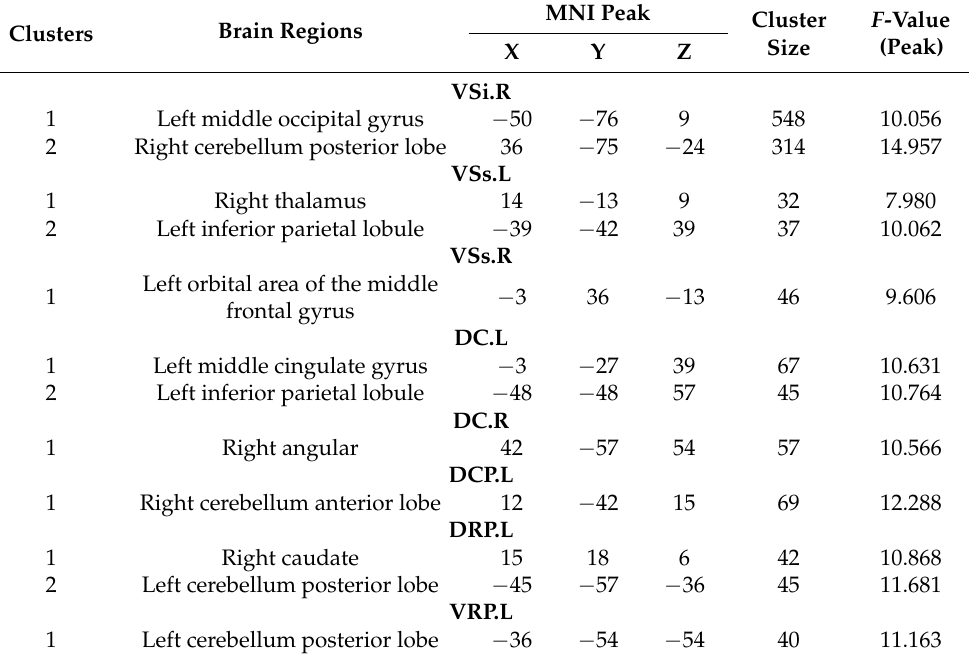
Table 2. Among three Group Differences in Striatal